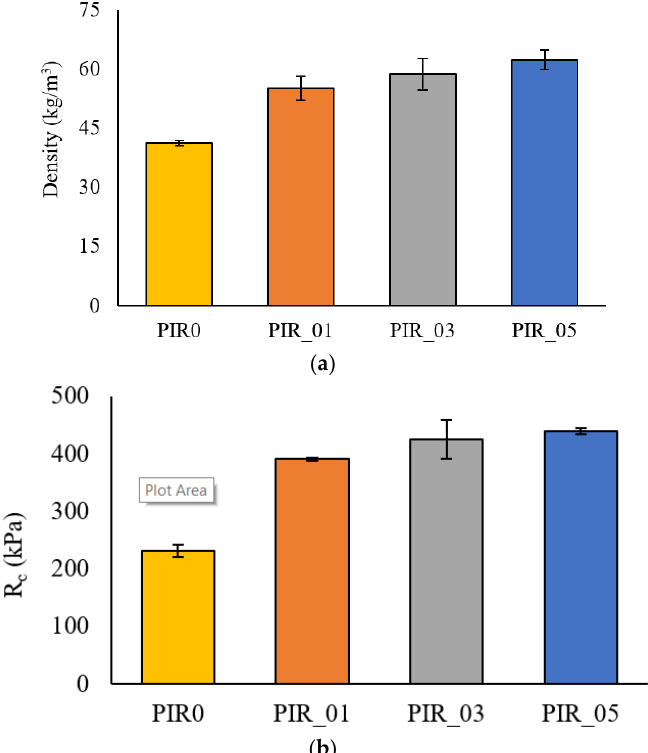
Figure 11. Effect of particle size on reinforced Polyisocyanurate foam properties: ( a ) density, ( b ) compressive strength.